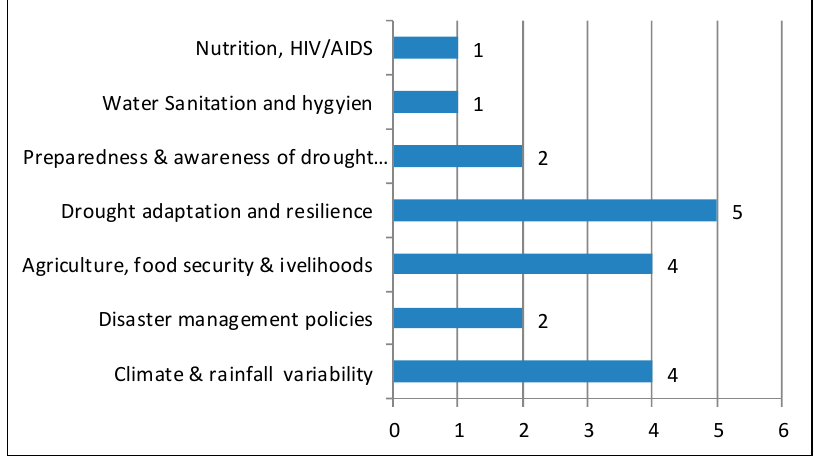
Figure 2. The variability of the studies’ objectives.